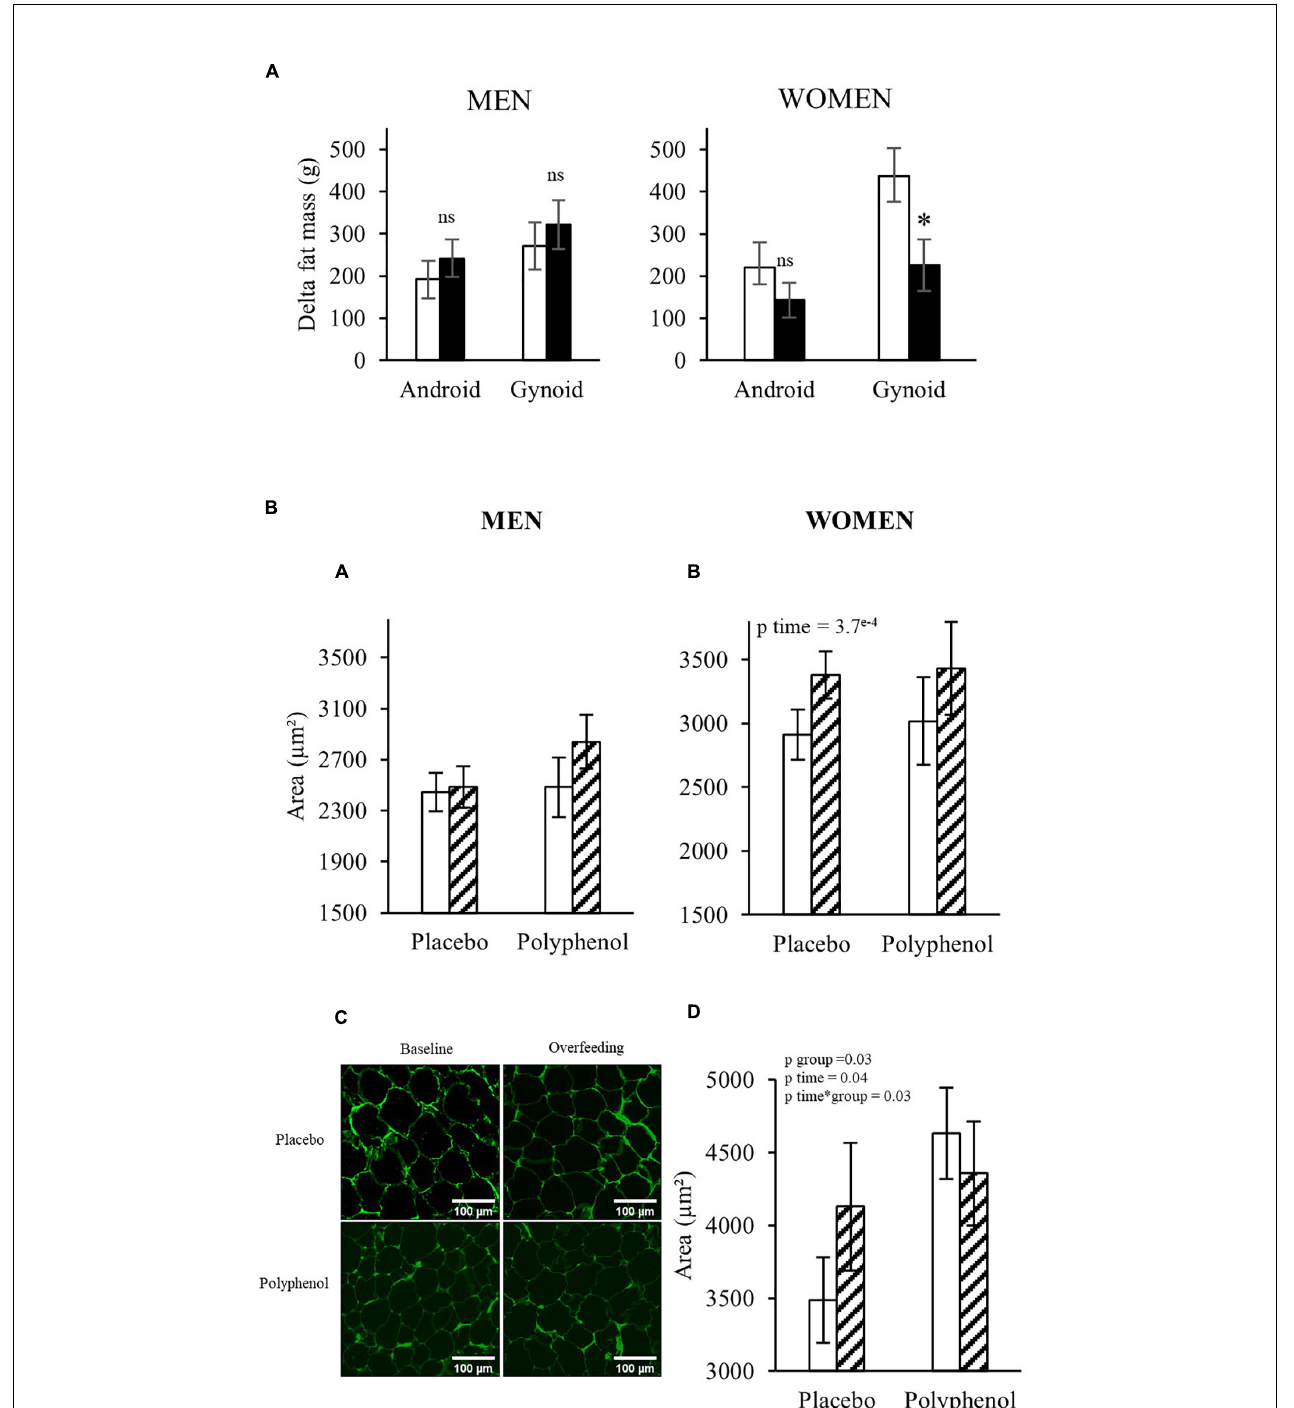
FIGURE 3 | (A) Evolution of android and gynoid fat mass in both populations analyzed by DEXA. T -test or Wilcoxon, ∗ p < 0.05. White bars: Placebo group; Black bars: Polyphenol group. Data are expressed as mean ± SEM. (B) Periumbilical adipocyte area in men (A) and women (B) and gluteal adipocyte area in women (D) before (D-7) and after overfeeding (D28) ( µ m 2 ) in each group. Periombilical adipose tissue pictures of a subject in the placebo and polyphenol group at baseline and after overfeeding (C) . ANOVA with repeated measures or non- parametric test when appropriate were performed to study the effect of time and the effect of the polyphenol supplementation. No effect of Time ∗ Group using ANOVA repeated measures, or non-parametric test, except for the Gluteofemoral adipocyte size in women. White bars: Baseline; Hatched bars: Overfeeding. Data are expressed as mean ± SEM.